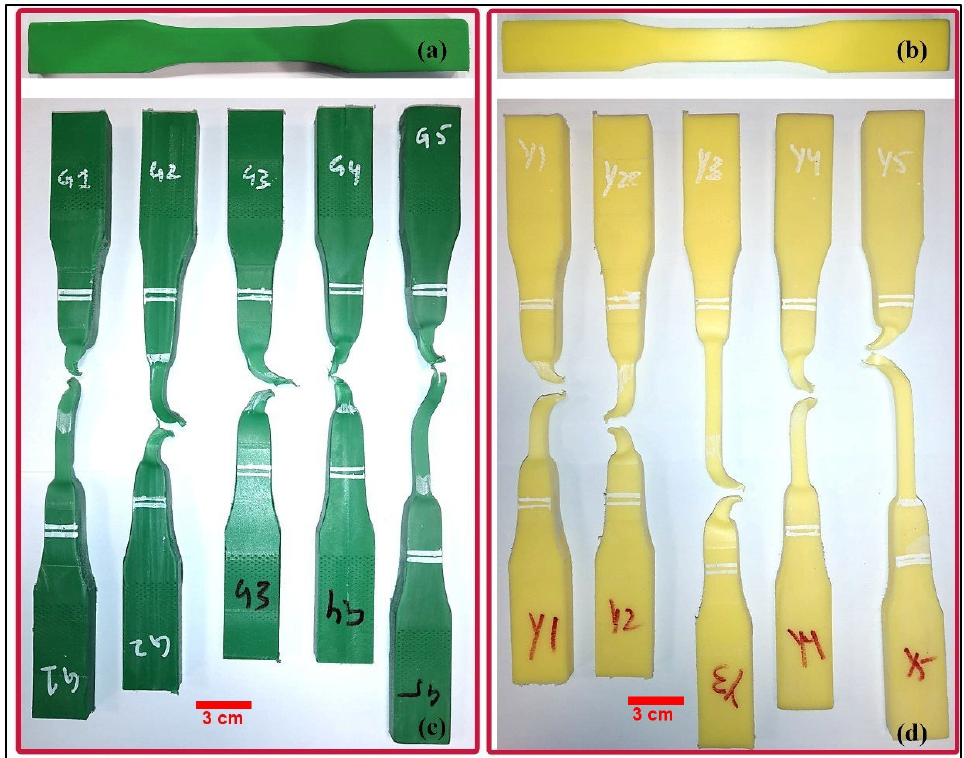
Figure 5 . Prepared tensile specimens of CB-3 ( a ); CB-4 ( b ); fractured tensile specimens of CB-3 ( c ); and CB-4 ( d ).